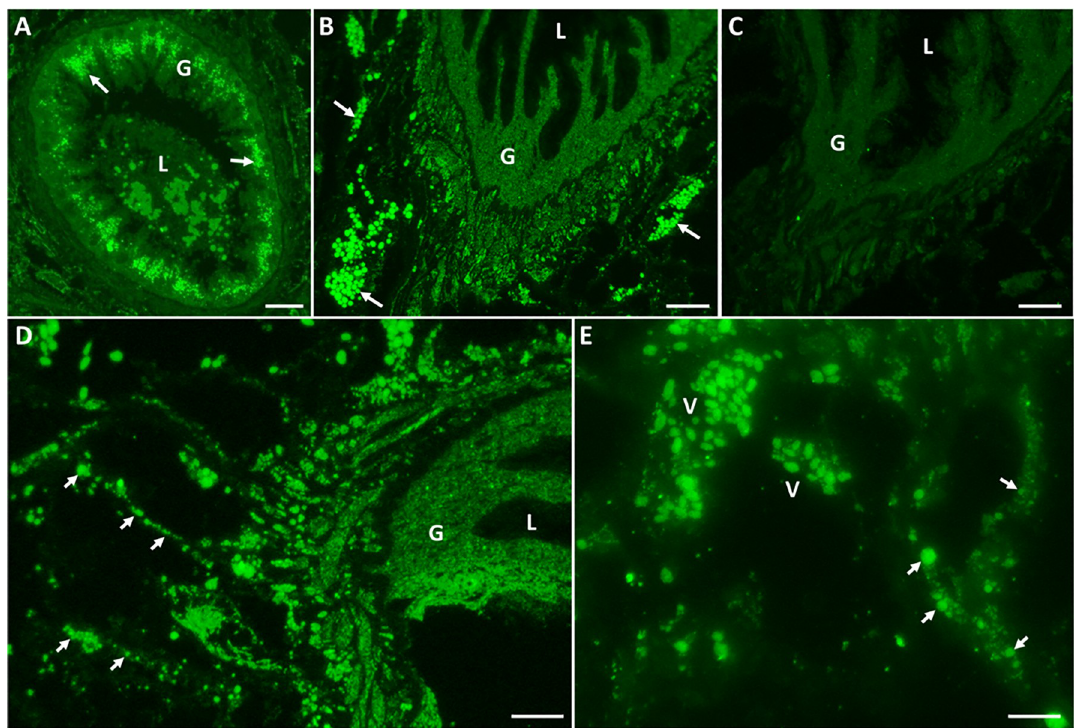
Fig 2. CD63 receptor-positive EVs are found in sub-gastrodermal regions of adult F . hepatica . Tissue sections of adult F . hepatica were probed with anti-cathepsin L (A) or anti-CD63 receptor antibodies (B, D-E) or with rabbit pre-immune serum (C). A. Specific cathepsin L immunoreactivity (arrows) can be seen within the gastrodermal cells (G) that line the parasite gut. L, gut lumen. B. Strong CD63 receptor immunolabeling is observed in vesicles that occur as distinct clusters (arrows) just beneath the gastrodermal cell layer. C. No specific immunofluorescence can be seen in these areas when sections were probed pre-immune control sera. D-E. CD63 receptor-positive vesicles (V) can be seen along duct-like structures (arrows) that converge upon the vesicle clusters in sub- gastrodermal regions of the adult fluke. Scale bars 25 μ m (A-C) or 10 μ m